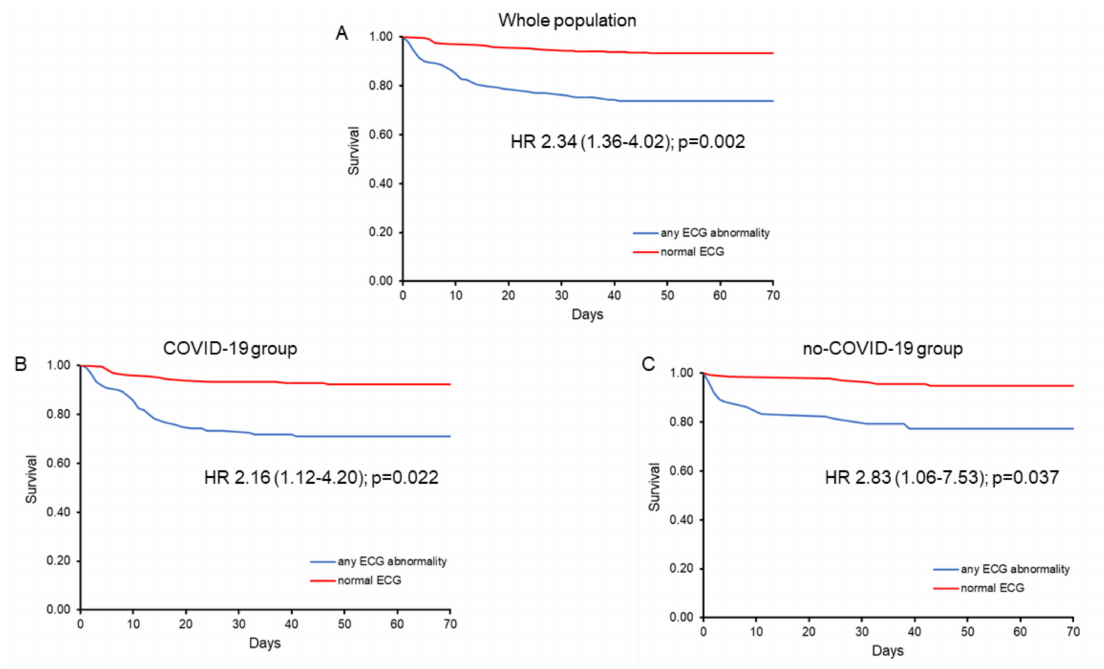
Figure 2. Kaplan–Meier survival curves of patients with and without the presence of any electrocardiogram abnormality in the whole population of patients hospitalized because of an acute infectious respiratory disease ( A ) and in the COVID-19 ( B ) and no-COVID-19 ( C ) groups. ECG = electrocardiogram; HR = hazard ratio (with 95% confidence